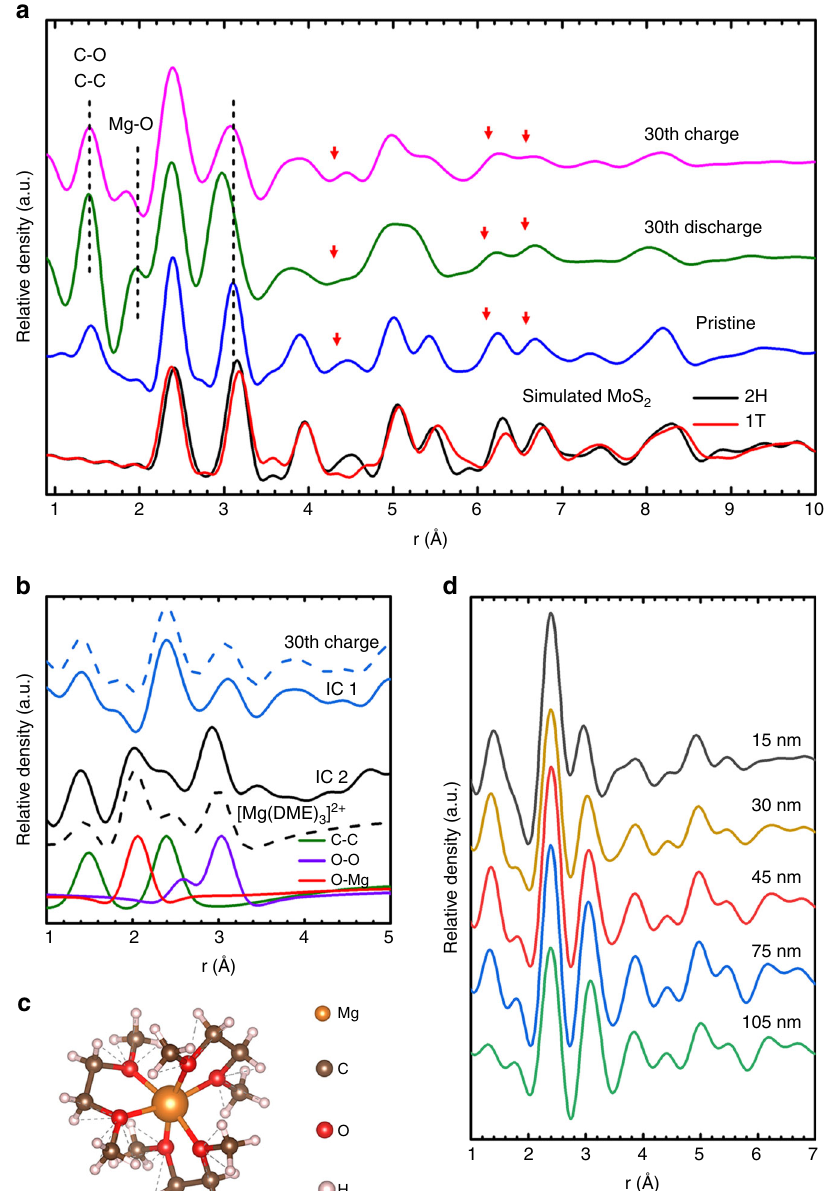
Fig. 6 PDF analysis and depth pro fi le. a PDF analysis of 4D-STEM diffraction patterns taken from the area highlighted in Supplementary Fig. 17. b ICA solution to the PDF curves and the simulated PDF of a [Mg(DME) 3 ] 2 + molecular cluster. c Molecular structure of a [Mg(DME) 3 ] 2 + cluster. d Local PDFs at a different depth from the surface of the 30th charged